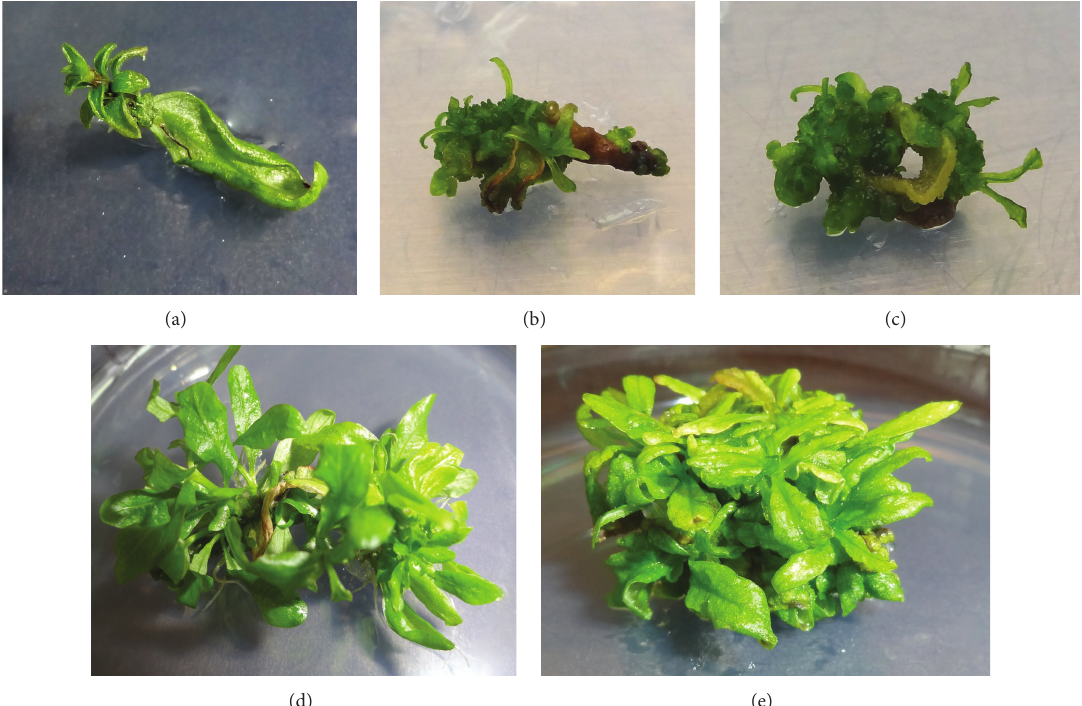
Figure 1: In vitro adventitious shoot regeneration of H. polysperma: (a) shoot induction from leaf tip, (b) multiple shoot initiation, (c) callus induction, and ((d) and (e)) multiple induced